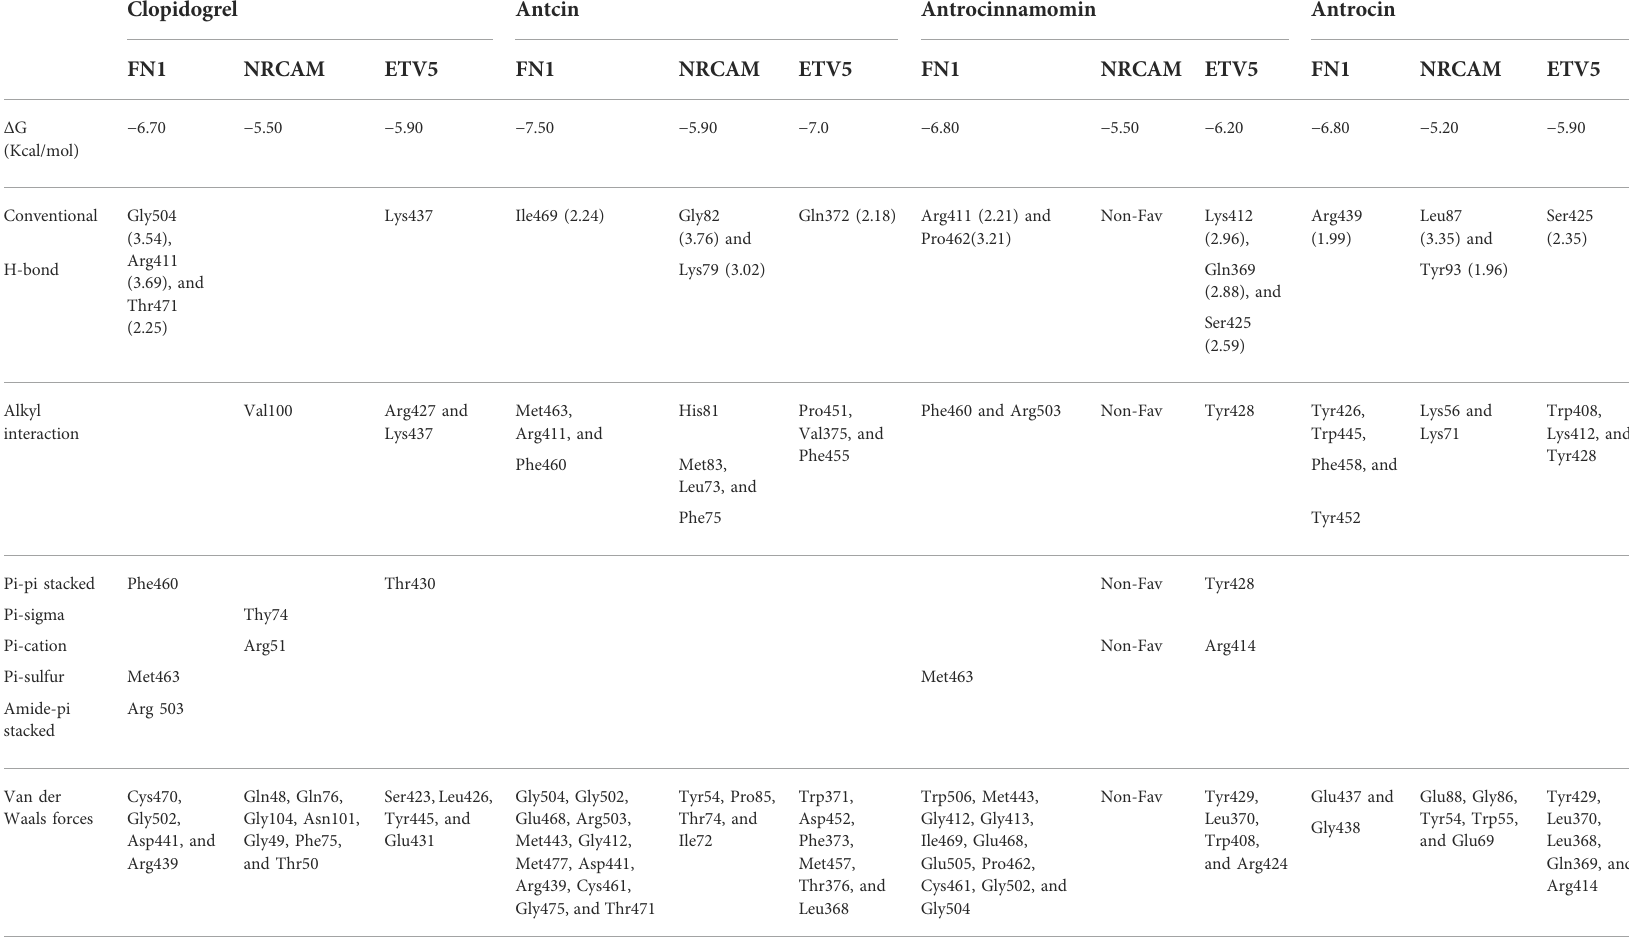
TABLE 2 Docking pro fi le of TTEPs with antrocinnamomin, antcin, and antrocin isolated from Taiwan Antrodia